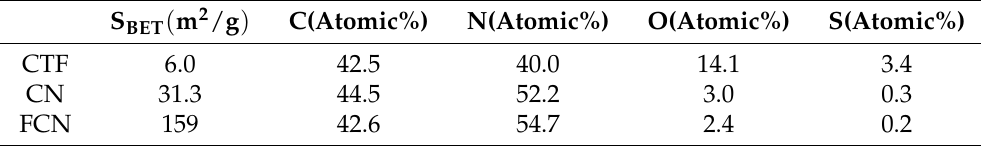
Table 1. Specific surface areas and XPS elemental compositions of the